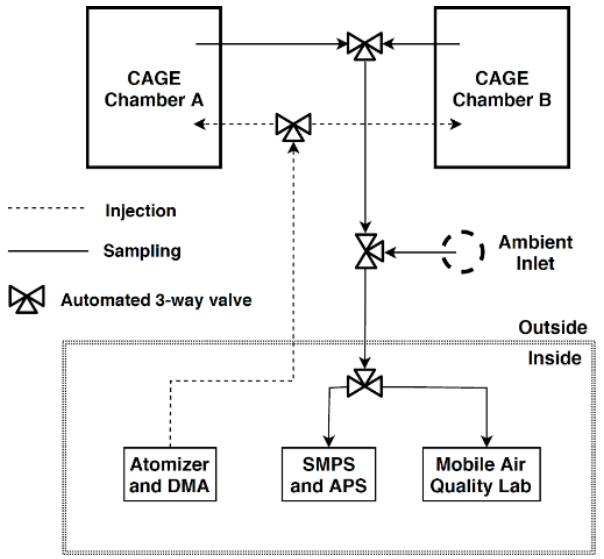
Figure 3. Placement and orientation of the CAGE chambers rela- tive to the instrument trailer, and the tubing and valve configuration used to inject particles into and sample particles from both CAGE